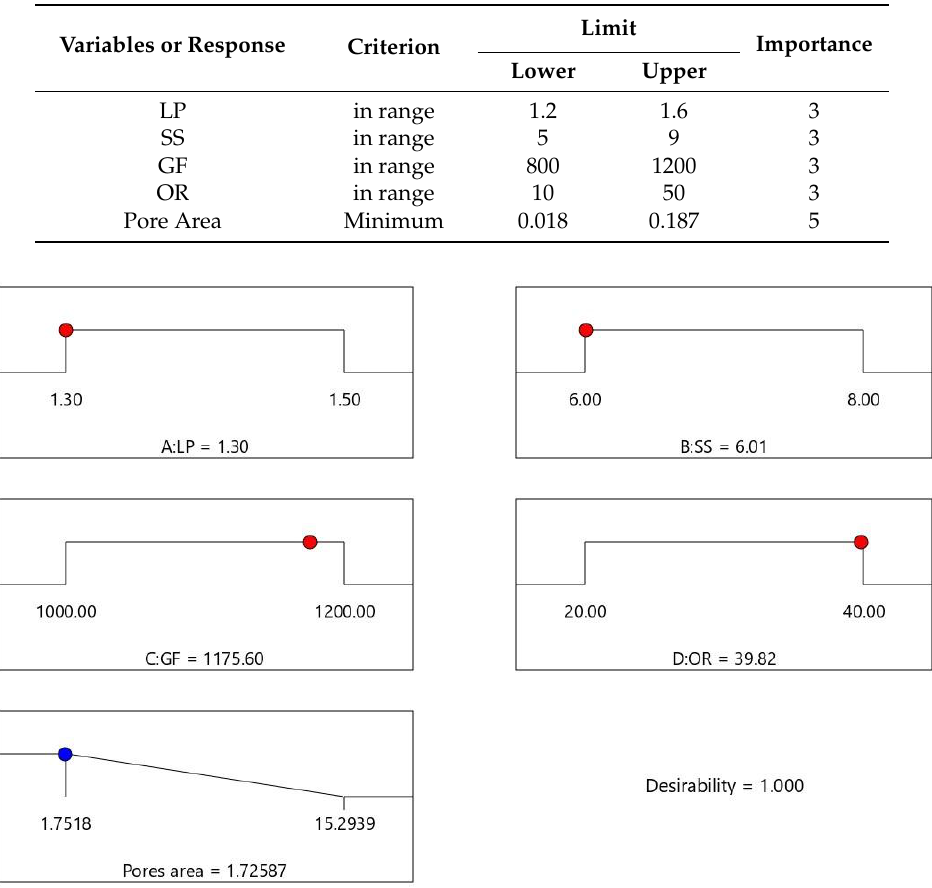
Figure 6. Optimization results of processing parameters and expected optimal pore area.